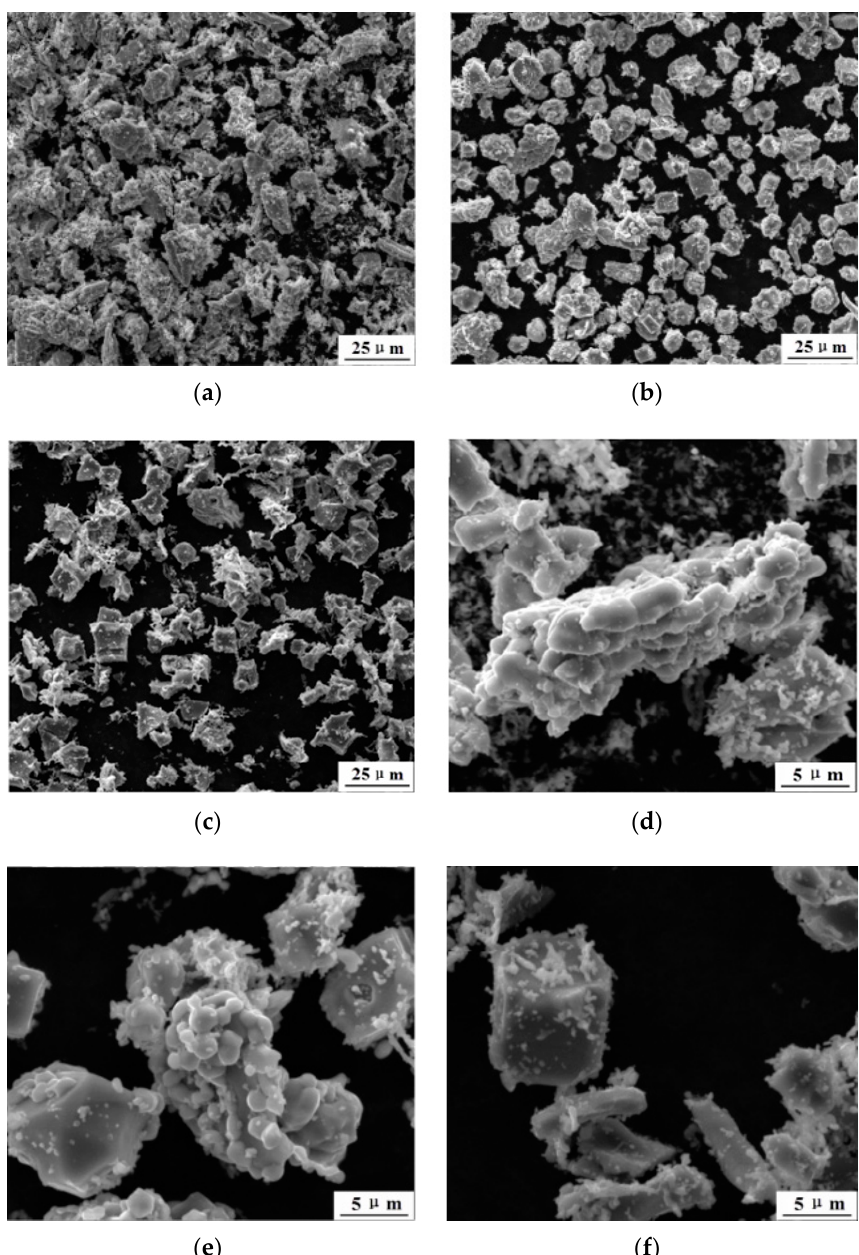
Figure 9. SEM images of carbides power after spheroidizing annealing: ( a ) and ( d ) No. 1; ( b ) and ( e ) No. 2; ( c ) and ( f ) No. 3.